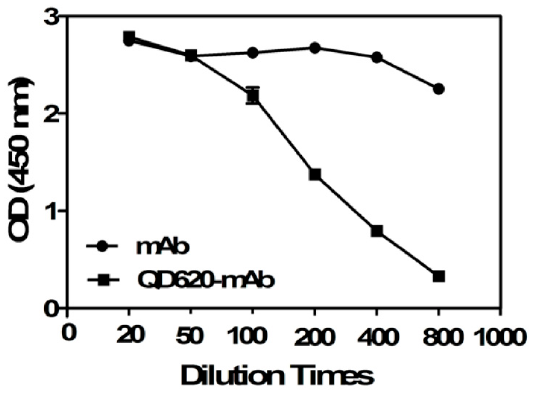
Figure 2. Comparison of the absorbance at 450 nm of mAb and QD620-mAb at different dilution times.